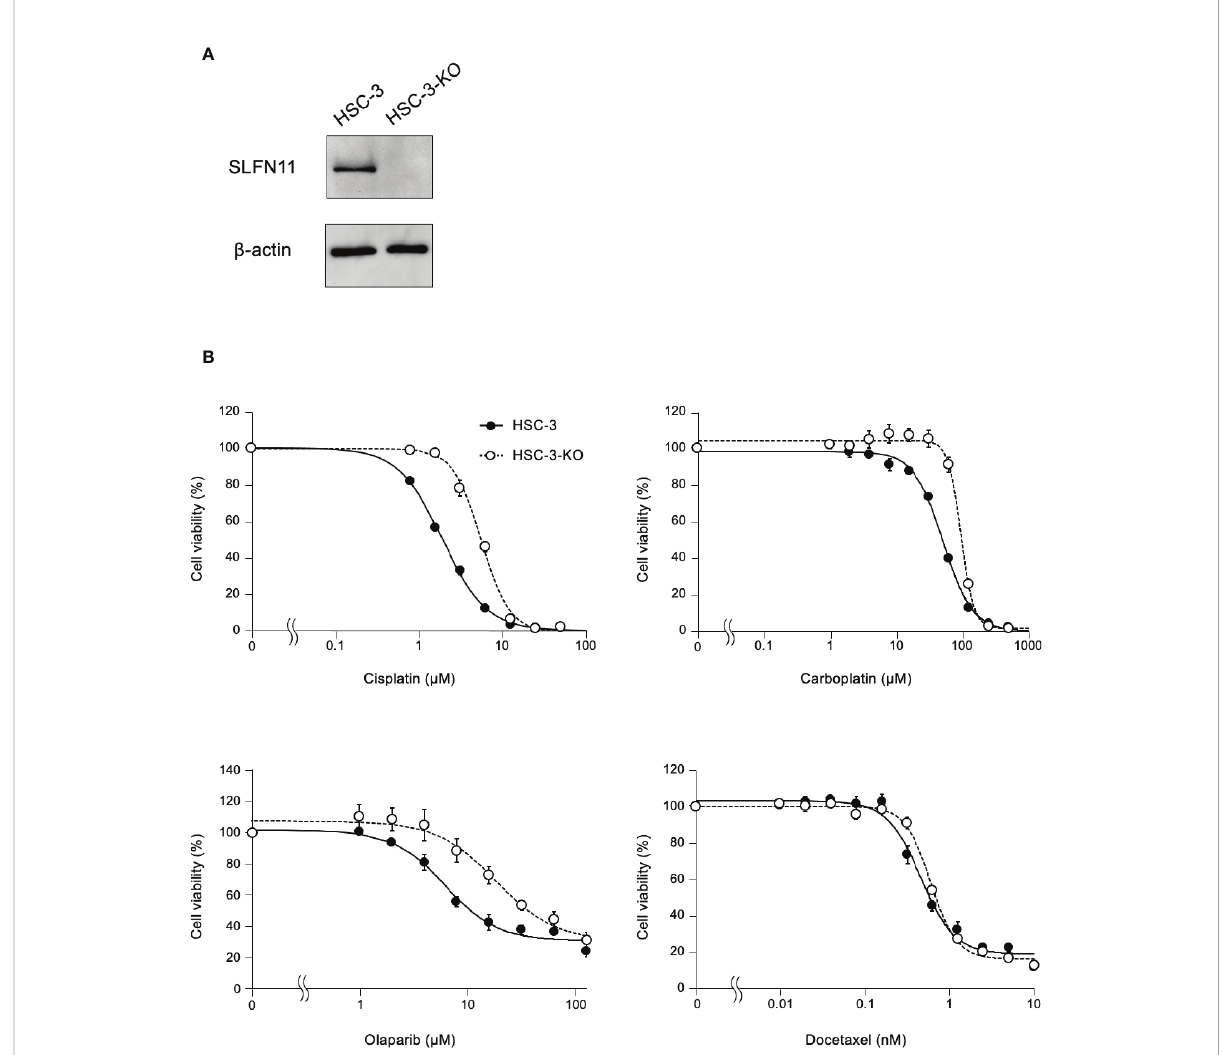
FIGURE 4 HSC-3 cells de fi cient in SLFN11 display reduced sensitivity to cisplatin, carboplatin, and olaparib. (A) SLFN11 -KO cells from HSC-3 cells (HSC-3-KO) were generated using the CRISPR/Cas9 method. Cell lysates prepared from these cells were subjected to immunoblot analysis with an antibody for SLFN11 and b -actin (loading control). (B) HSC-3-KO and parental HSC-3 cells were exposed to cisplatin and carboplatin for 48 h, or olaparib and docetaxel for 72 h at the indicated concentrations. Cell viability was determined using a Cell Counting Kit-8 assay and the values were normalized to those of untreated cells. Data are presented as the mean ± standard error of the mean from three independent